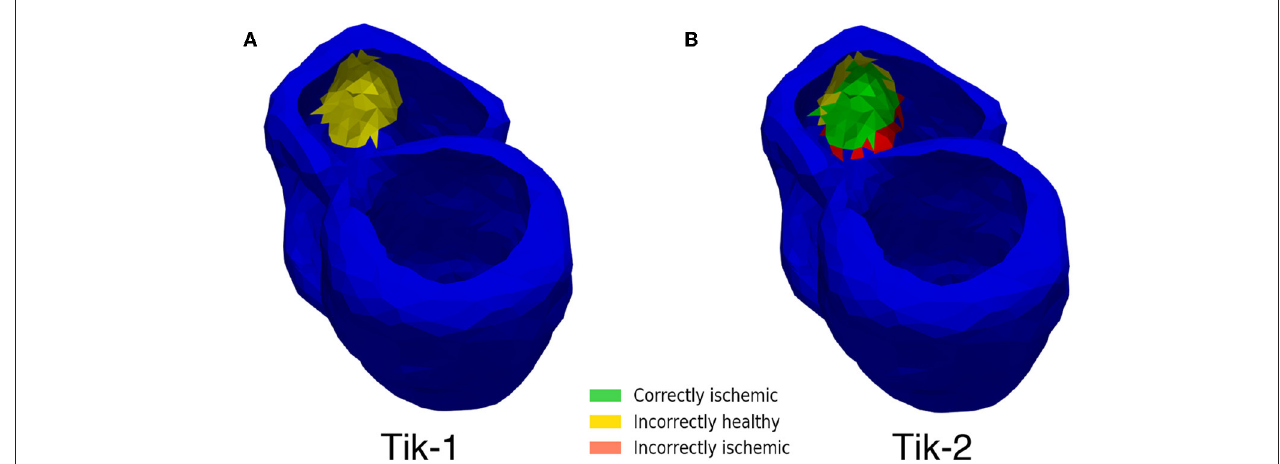
FIGURE 9 | Twelve lead ECG using BSP produced with the human ventricle-torso model. Simulation using healthy control conditions (black) and 5 ischemic lesion locations (5 colours). The y axis has been normalised between 1 and − 1.